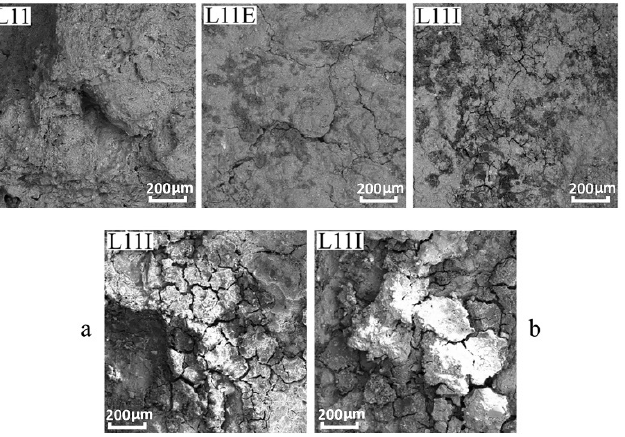
Figure 9. SEM micrographs for Monteoru sample L11 ( a , b ) details for the inner